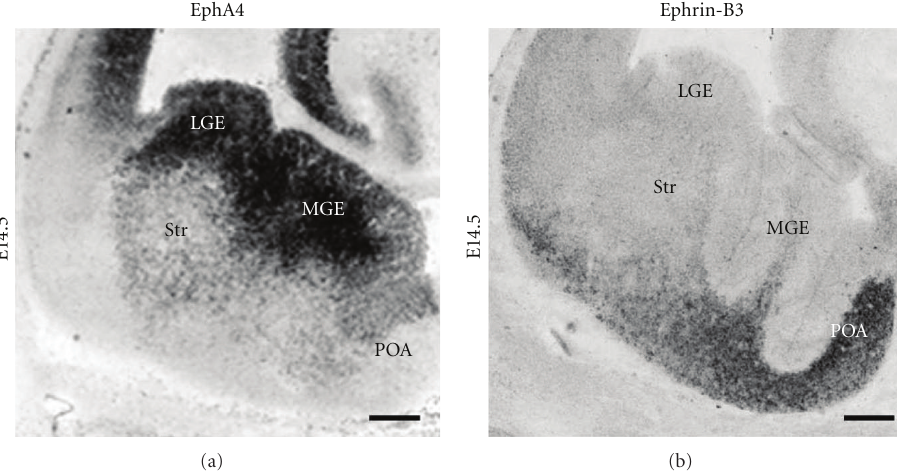
Figure 3: Complementary EphA4 and ephrin-B3 in situ hybridization expression patterns. On embryonic day E14.5 EphA4 and ephrin-B3 are complementary expressed in the basal telencephalon of mouse brains. Based on these expression patterns several predictions about the functional role of these wiring molecules on interneuron migration could be made (see text for details). Scale bar: 100 μ m.